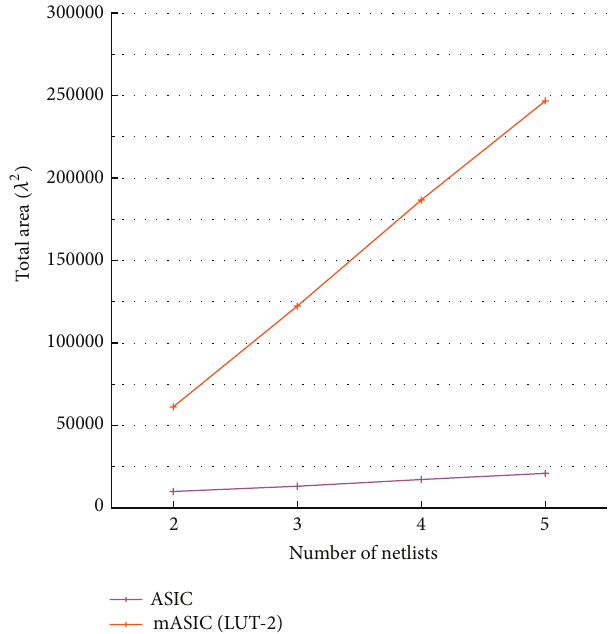
Figure 19: Total area comparison between ASIC and LUT-2 based